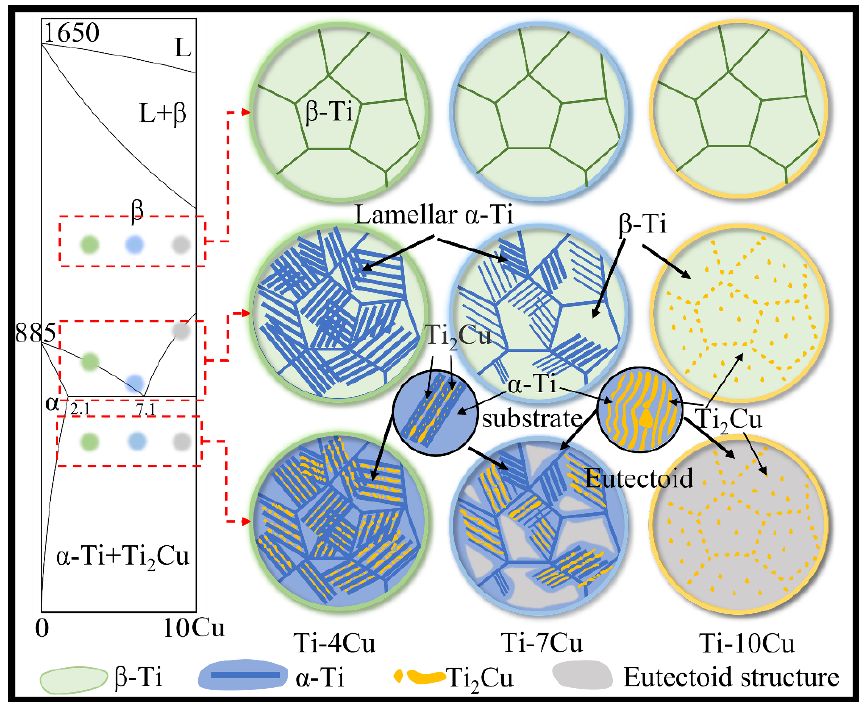
Figure 5. Section of Ti-Cu phase diagram and schematic views of microstructure transformation of Ti-xCu alloys during solidification.